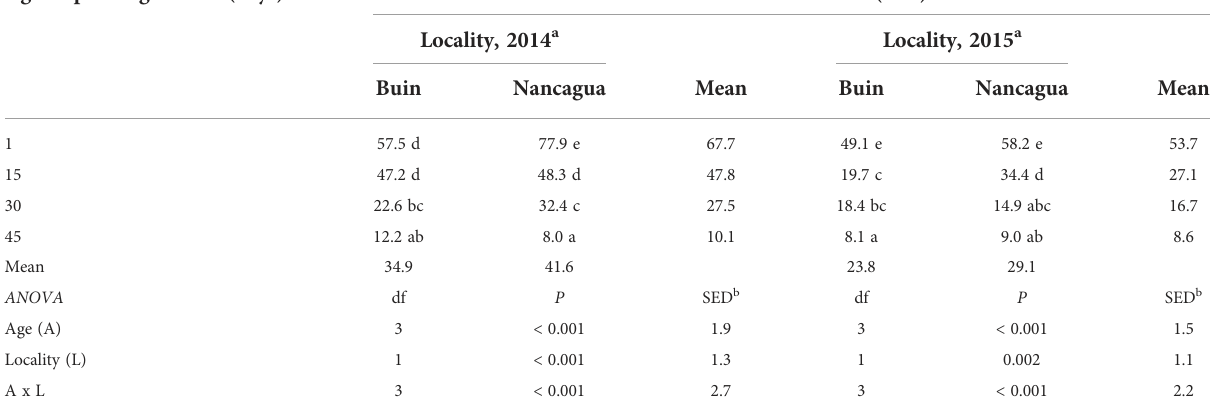
TABLE 2 Vascular discoloration (mm) caused by arti fi cial inoculation of Phaeomoniella chlamydospora at different ages of pruning wounds (1, 15, 30, and 45 days after pruning) in the commercial vineyards cv. Cabernet Sauvignon during eight months in two localities (Buin and Nancagua), Central